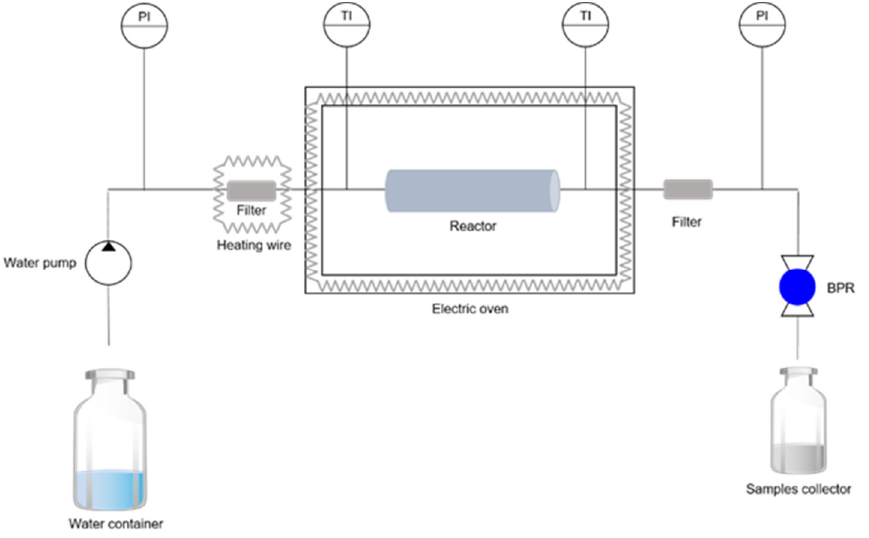
Figure 1. Schematic representation of the SBW apparatus used for SBW treatment. PI: pressure indicators; TI: temperature indicators.